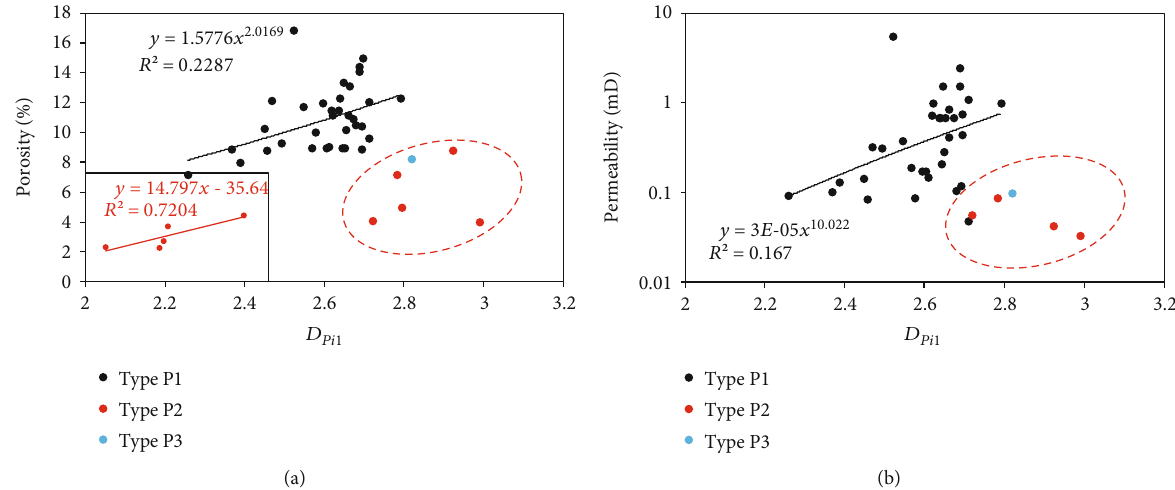
Figure 6: Double-logarithm coordination showing the relationship between the lg ð N specimen with multiple segments from S46. D modi fi ed fractal dimension values; boundary-boundary between self- and non-self-similar sets.